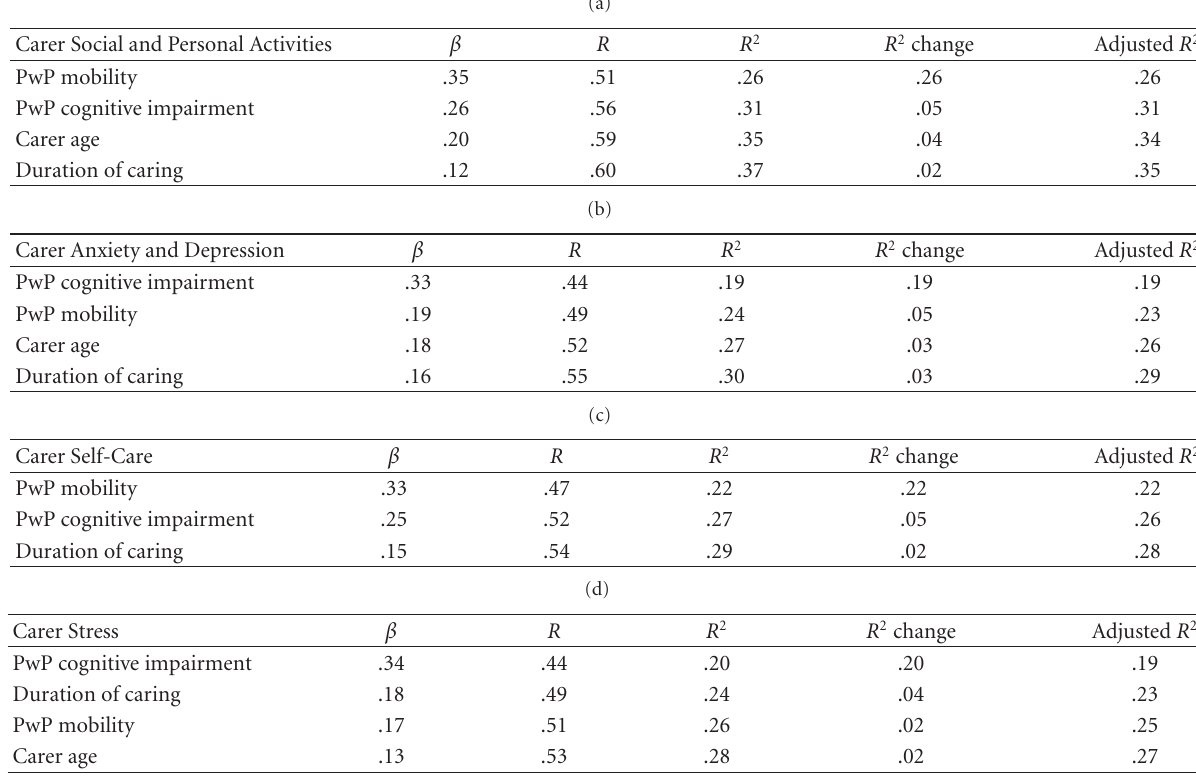
Table 4: (a) Predictors of PDQ-Carer Social and Personal Activities, (b) predictors of PDQ-Carer Anxiety and Depression, (c) predictors